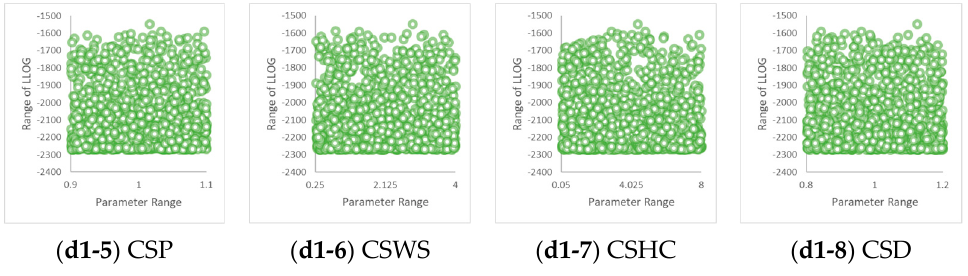
Figure 5. Event 1 Dotty plot of behavioral parameters based on formal and informal likelihood. ( a1-1 − a1-8 ) LNSE results; ( b1-1 − b1-8 ) LPBIAS results; ( c1-1 − c1-8 ) LRSR results; ( d1-1 − d1-8 ) LLOG results.